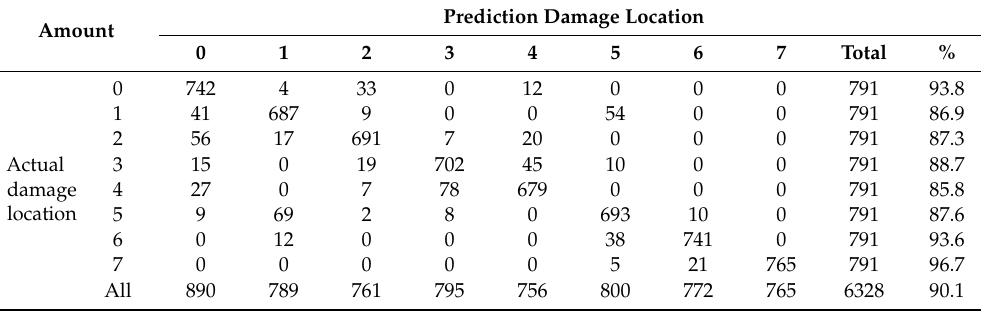
Table 9. Test results of damage classification in dataset